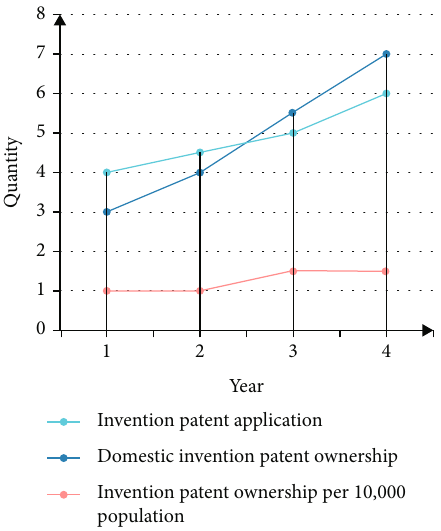
Figure 4: Patent-related data in the fi eld of arti fi cial intelligence in China.